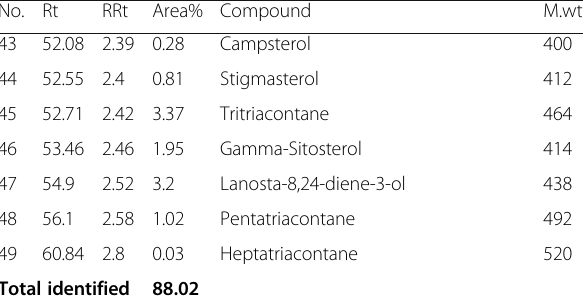
Table 7 GC/MS analysis of unsaponifiable matter of Thevetia peruviana leaves